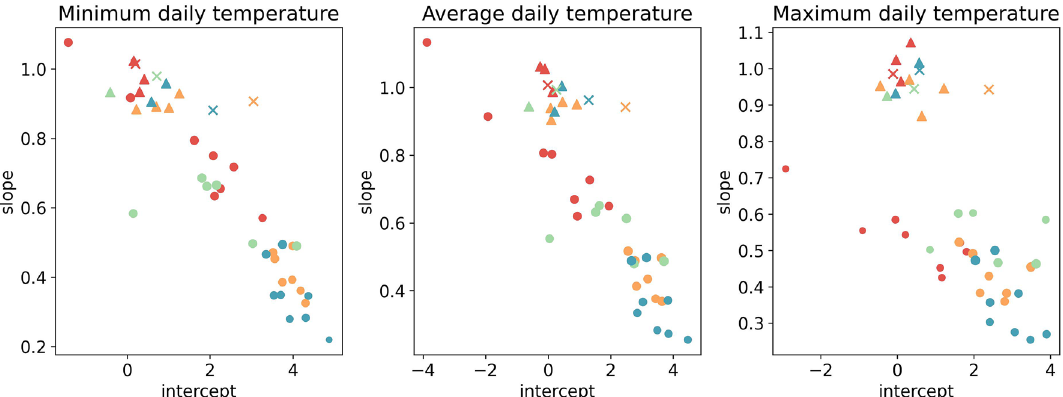
Figure 3. Scatterplots of the slopes m i versus the intercepts q i of the regression lines T i = m i T MS + q i modelling the relation between gridded minimum (left), mean (centre) and maximum (right) daily temperatures and catch basins (dots), weather station (x) and external (triangle) temperatures for the cities of Lugano (blue), Basel (green), Lausanne(cyan) and Zurich (red).